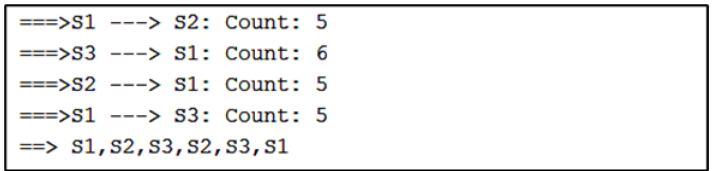
Figure 16. Algorithm 2 ’ s visualization of Path 3 vectors.